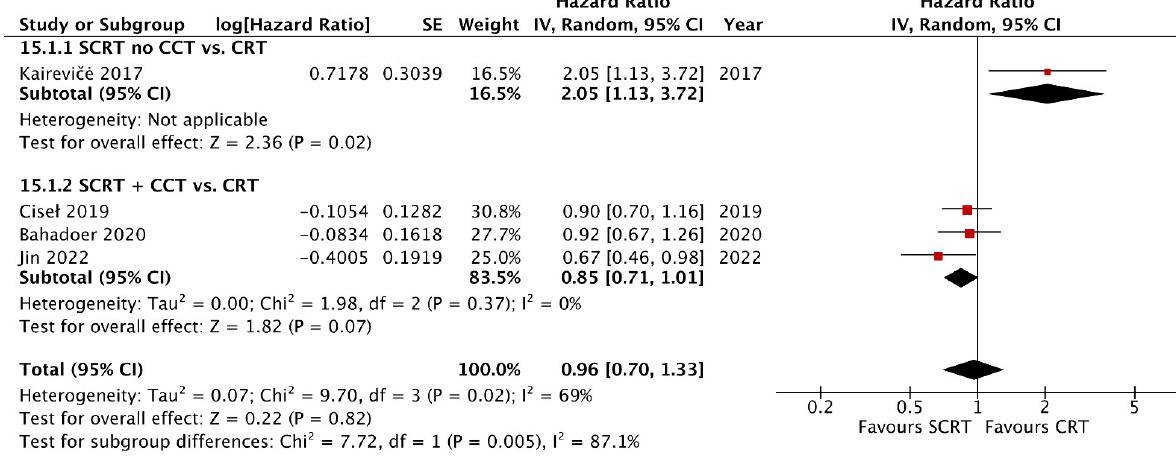
Figure 6. Forest plot of the overall survival (OS) by Hazard ratio (HR).